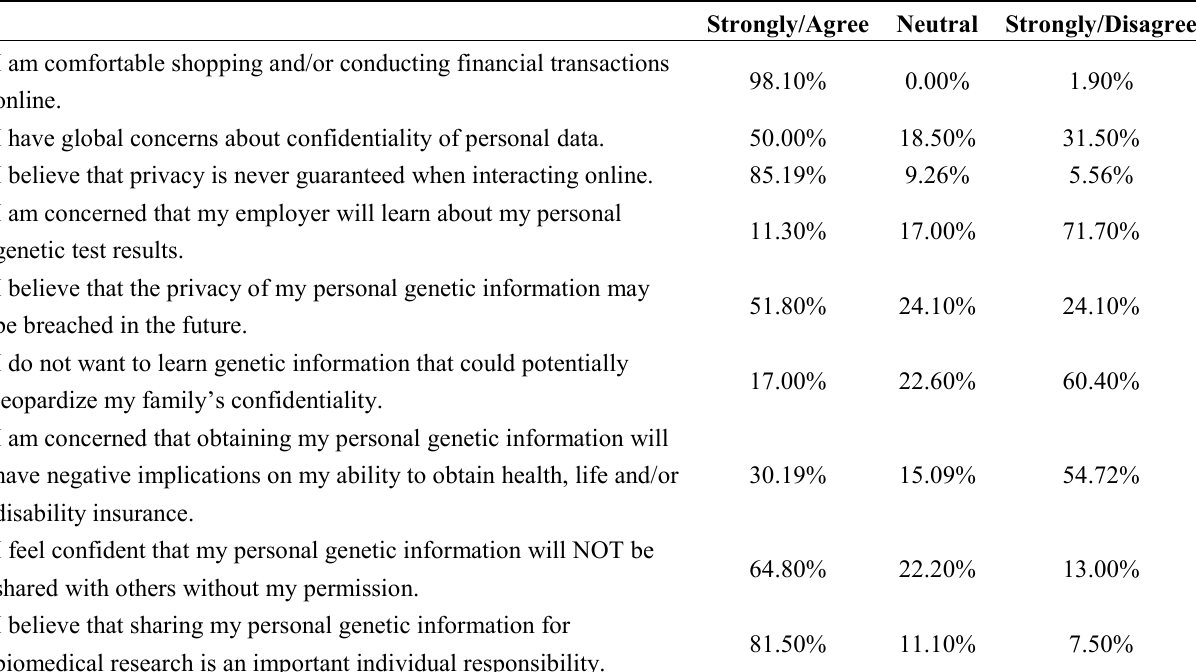
Table 3. Attitudes towards privacy among study